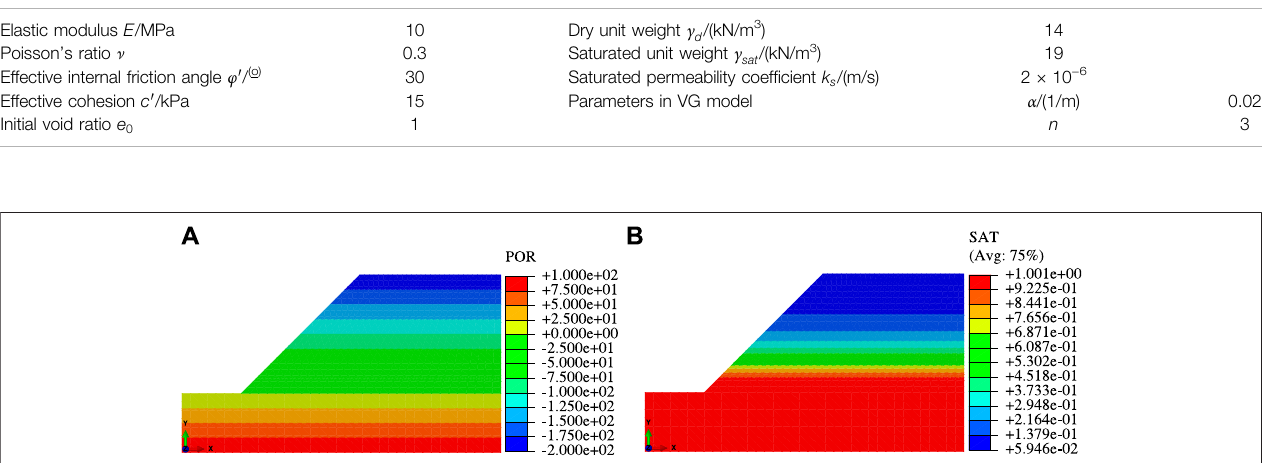
TABLE 3 | Geotechnical properties of soil.